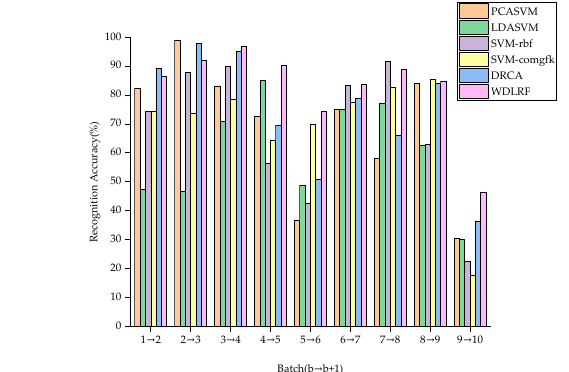
Figure 3. Two-dimensional principle component scatter points of the source and target domain feature representations after using the proposed WDLFR method.